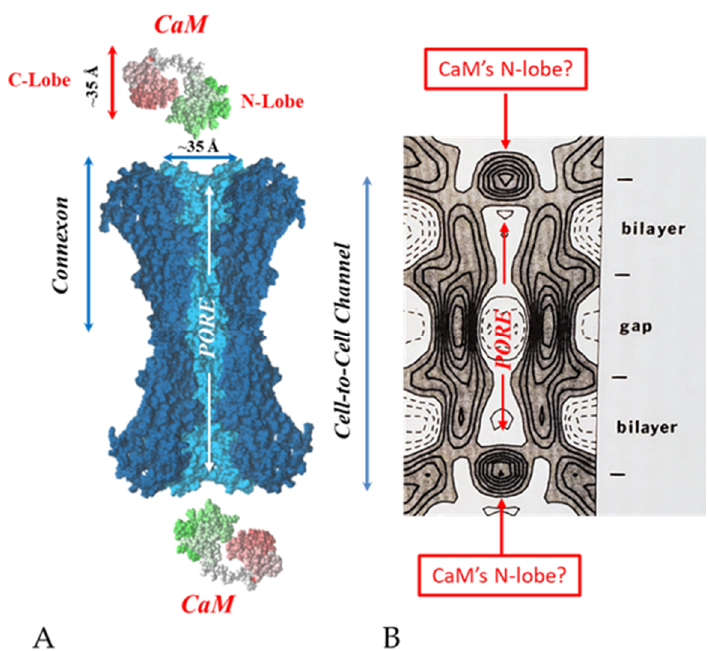
Figure 19. Both the positively charged channel’s mouth and the negatively charged CaM lobes are ~35 Å in size ( A ). Thus, a CaM lobe could fit well within the positively charged connexon’s mouth ( A ). Significantly, the three-dimensional structure of gap junctions isolated from mouse liver ( B ) demonstrates that the channel of isolated (crystalline) junctions is impermeable to 50% sucrose, proving that it is closed at each cytoplasmic end by a particle that prevents sucrose entry ( B ). Our hypothesis is that the blocking particle is the CaM’s N-lobe ( B ). Both the CaM and connexon images ( A ) were provided by Dr. Francesco Zonta (VIMM, University of Padua, Italy. ( B ) was reproduced from ref. [121] with permission from the Journal of Molecular Biology and the Cold Spring Harbor Laboratories.